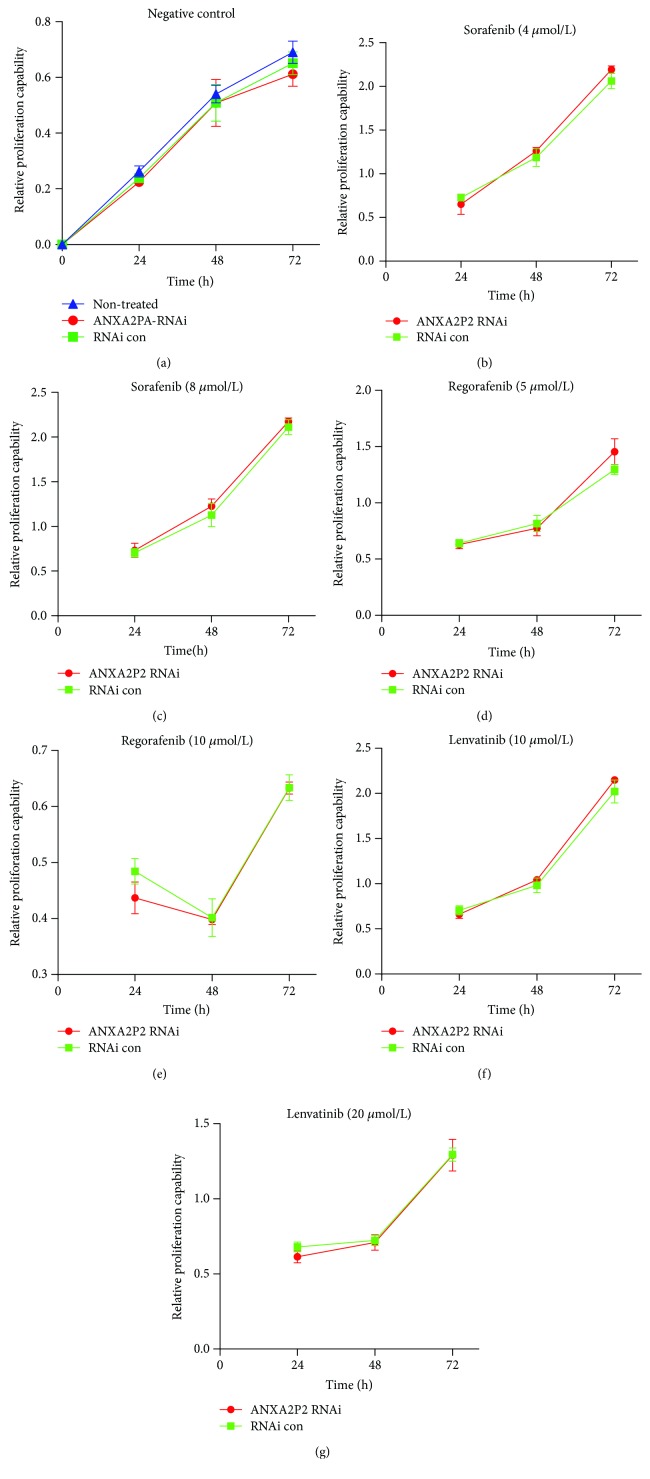
CCK8 assay of Hep3B cells transfected with si-ANXA2P2 or negative control siRNA when treated with negative control, sorafenib (4 μmol/L, 8 μmol/L), regorafenib (5 μmol/L, 10 μmol/L), and lenvatinib (10 μmol/L, 20 μmol/L), respectively, for three days and measured at the time points of 24, 48, and 72 h. There was no significant difference in relative proliferation capability between the no-treatment group, negative control siRNA group, and si-ANXA2P2 group (a). The relative proliferation capability was not significantly different between the negative control siRNA group and the si-ANXA2P2 group when administered with sorafenib (b, c), regorafenib (d, e), and lenvatinib (f, g) with different concentrations at the time points of 24, 48, and 72 h.